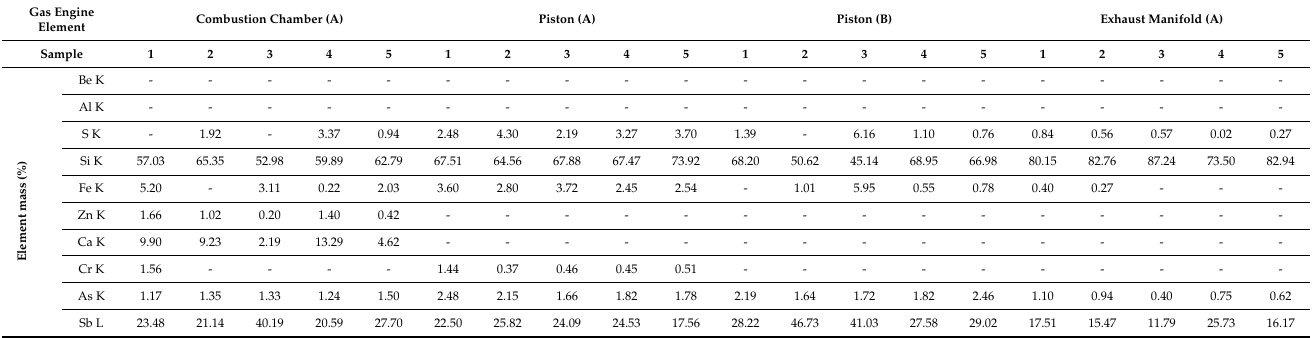
Table 2. Chemical composition of extreme layers of deposits (landfills A–C), weight share (%).